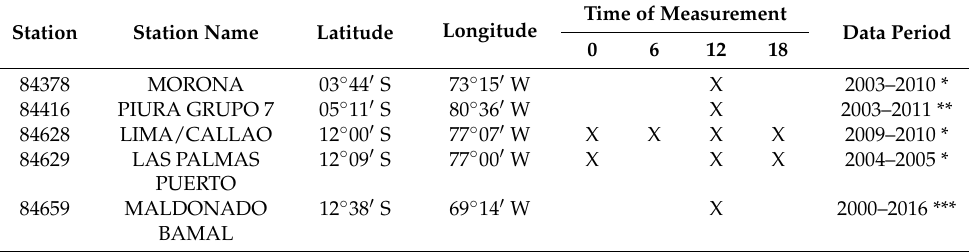
Table 1. Name of aerological stations that were used for the verification of MOD05 and ERA-Interim